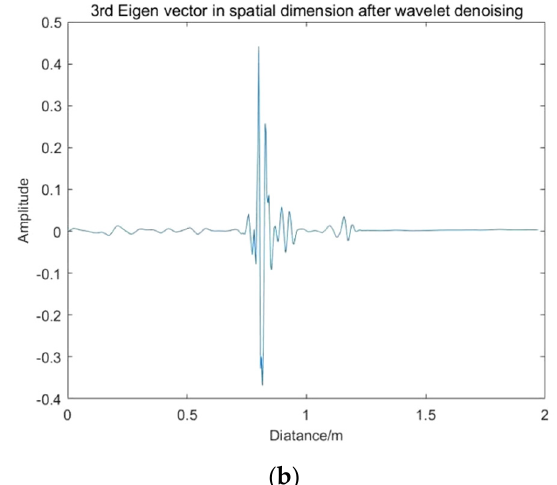
Figure 14. Vital signs extraction results of each principal component: ( a ) Vital signs extraction of first temporal eigenvector; ( b ) Vital signs extraction of second temporal eigenvector; ( c ) Vital signs extraction of third temporal eigenvector.